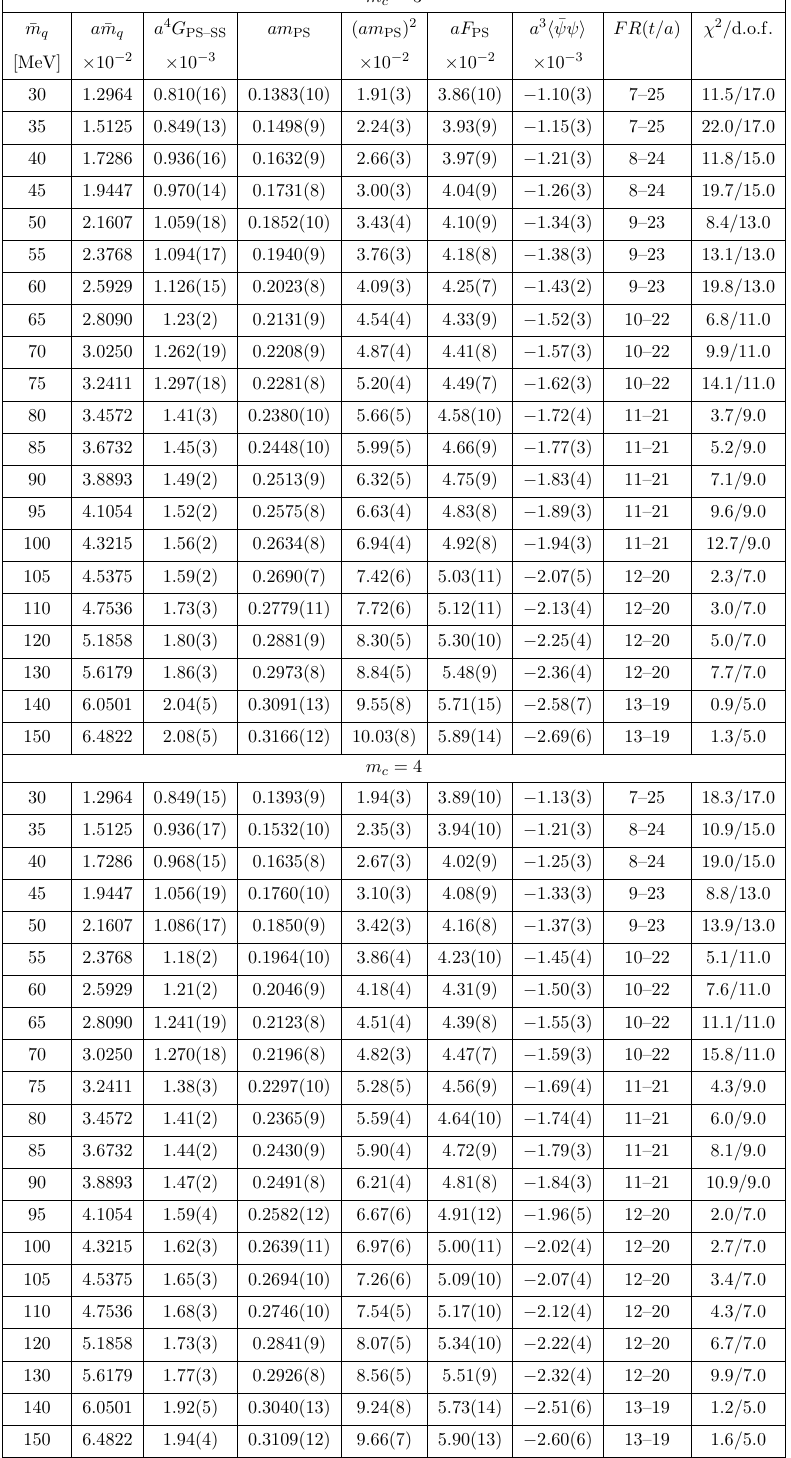
Table 26 . The (cid:12)tting results of a 4 G PS{SS and am PS together with the analytic results of the square of the pseudoscalar mass ( am PS ) 2 , decay constant aF PS , and chiral condensate a 3 h (cid:22) i . The magnetic charges of the con(cid:12)gurations are m c = 3 and m c =